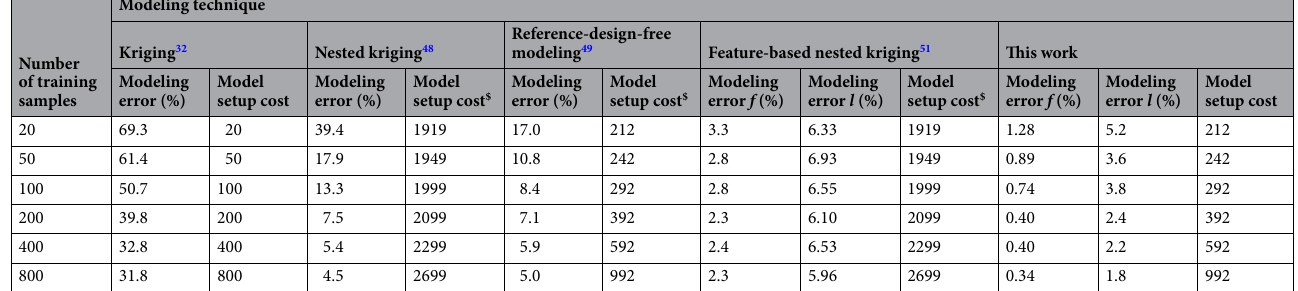
The results of Tables 4, 5 and 6 demonstrate that carrying out the modeling process at the level of the response features allows for achieving superior accuracy of representing the characteristic points relevant to the assumed design objectives at a remarkably small computational cost. For all the benchmark antennas, the proposed sur- rogate allows for achieving accuracy of less than one percent for training data sizes containing merely 50 samples from the constrained domain. Observe that the total cost of training data acquisition includes also the cost of generating 106, 230, and 192 observables for each antenna, respectively, which are necessary to define the sur- rogate domain. Even when taking into account these additional computational expenses, our approach requires as low as 126, 250 and 212 data samples to assess the operating frequencies of each antenna structure with the